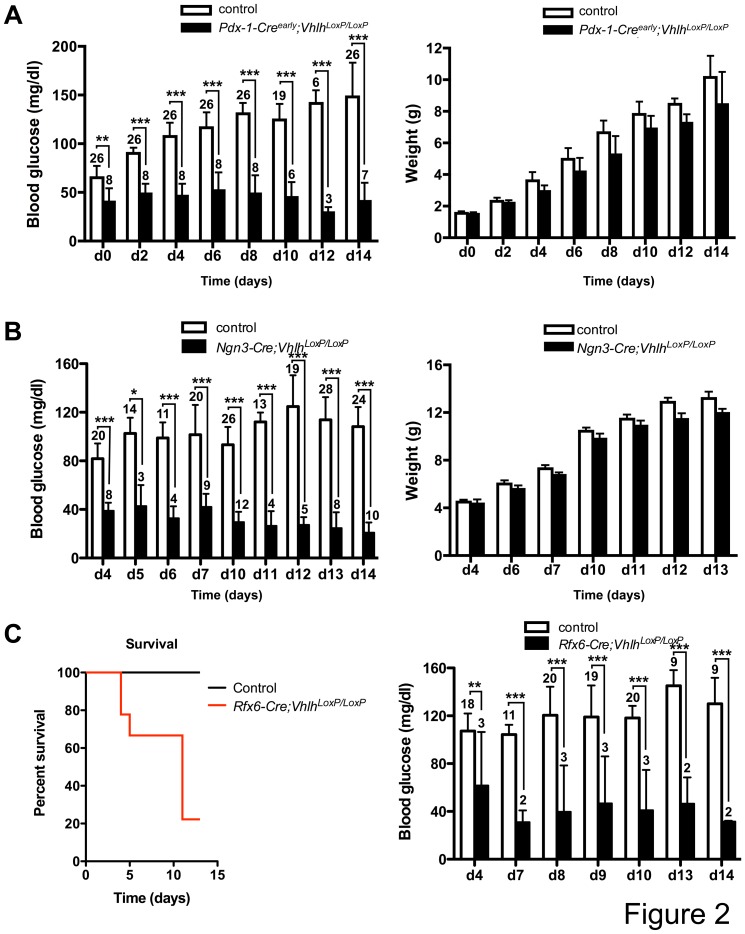
Defective insulin secretion in islets depleted of Vhlh.
A
. Left, VHL depletion in pancreatic progenitors (Pdx-1-Creearly;VhlhLoxP/LoxP) leads to severe hypoglycemia (black bars) while control littermates (open bars) are normoglycemic. N numbers are noted on the bar graphs. Right, comparison of weight gain between control (open bars) (n = 5) and Pdx-1-Creearly;VhlhLoxP/LoxP (black bars) (n = 6) pups. B. Left, VHL depletion in endocrine progenitors (Ngn3-Cre;VhlhLoxP/LoxP) leads to severe hypoglycemia (black bars) while control littermates (open bars) are normoglycemic. N numbers are noted on the bar graphs. Right, comparison of weight gain between control (open bars) and Ngn3-Cre;VhlhLoxP/LoxP (black bars) pups. Four control and three mutant animals were analyzed for the Ngn3-Cre;VhlhLoxP/LoxP cohort. C. Left, Survival curve of Rfx6-Cre;VhlhLoxP/LoxP mice (n = 9) compared to control (n = 27) littermates. Right, VHL depletion in pancreatic progenitors (Rfx6-Cre;VhlhLoxP/LoxP) leads to severe hypoglycemia (black bars) while control littermates (open bars) are normoglycemic. N numbers are noted on the bar graphs. *p<0.05, **p<0.005, ***p<0.0005. Error bars represent standard deviation.